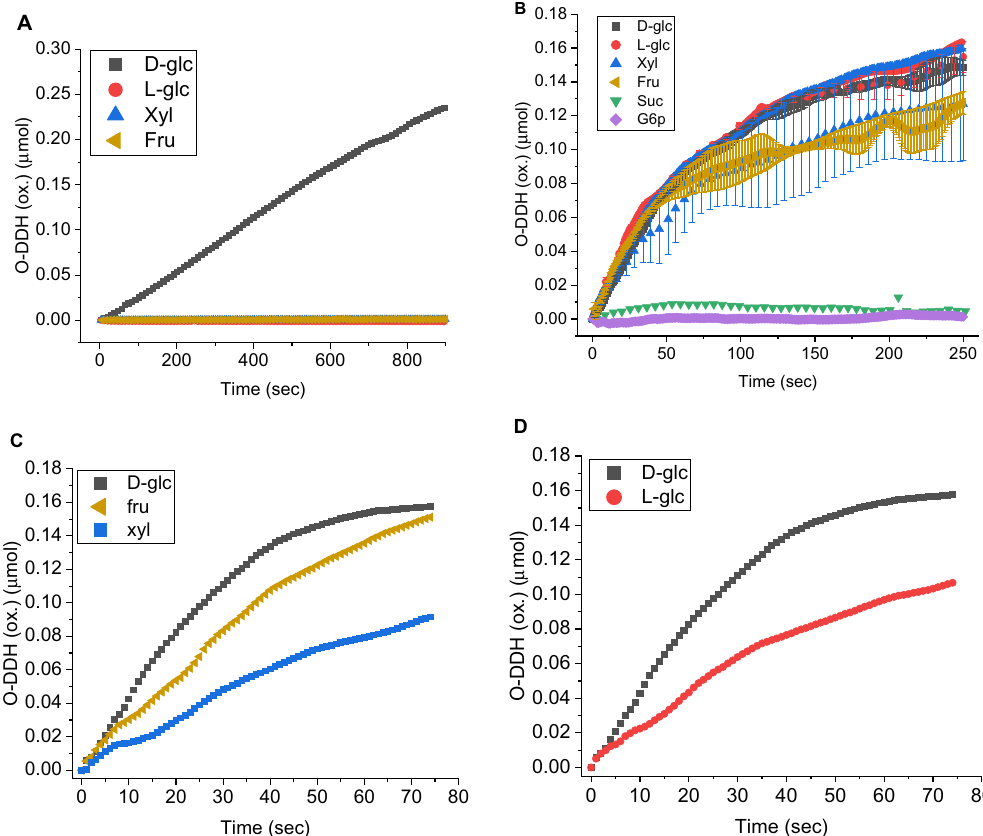
Figure 2. ( A ) The lack of activity of free GOx in solution towards fructose, xylose, and l-glucose (overlapping lines at the bottom), compared to the activity towards d-glucose 34 . ( B ) The activity of GOx@Au towards fructose, xylose and l-glucose and d-glucose (under saturation conditions of sugars concentration of 89.5 mM). Typical error bars of each of the monosaccharides are indicated in this figure, using the same color code. ( C ) The activities of GOx@Au towards fructose and xylose at non-saturation sugar concentrations of 15 mM and 12.5 mM, respectively. ( D ) The activity of GOx@Au towards the two enantiomers of glucose (non-saturation sugar concentrations of 15